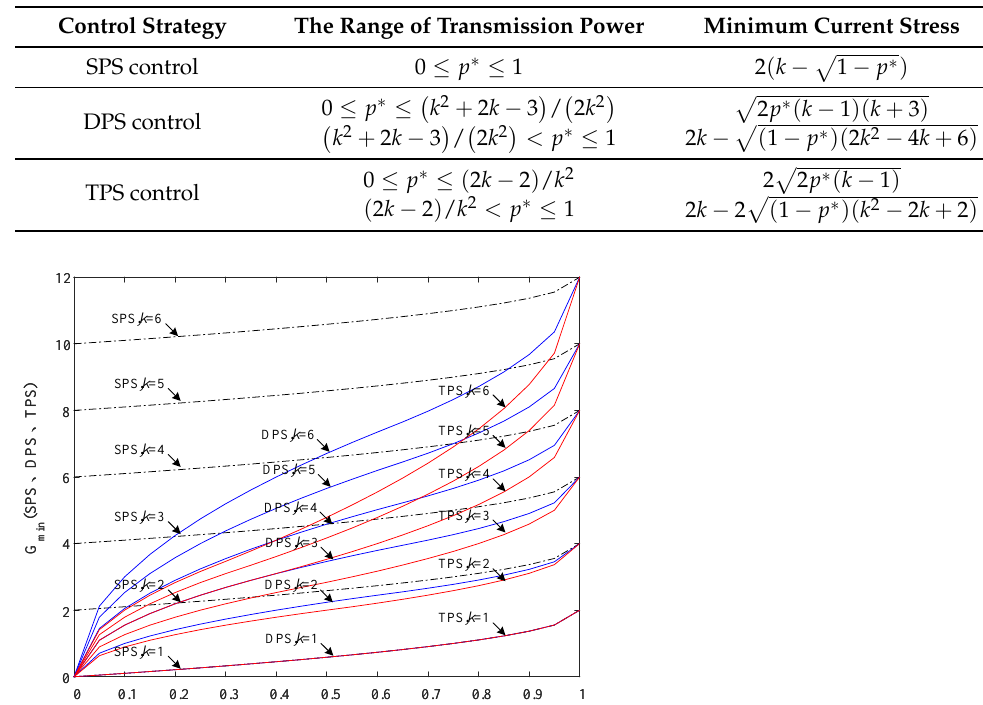
Table 3. Minimum current stress of the DAB converter under different control strategies.